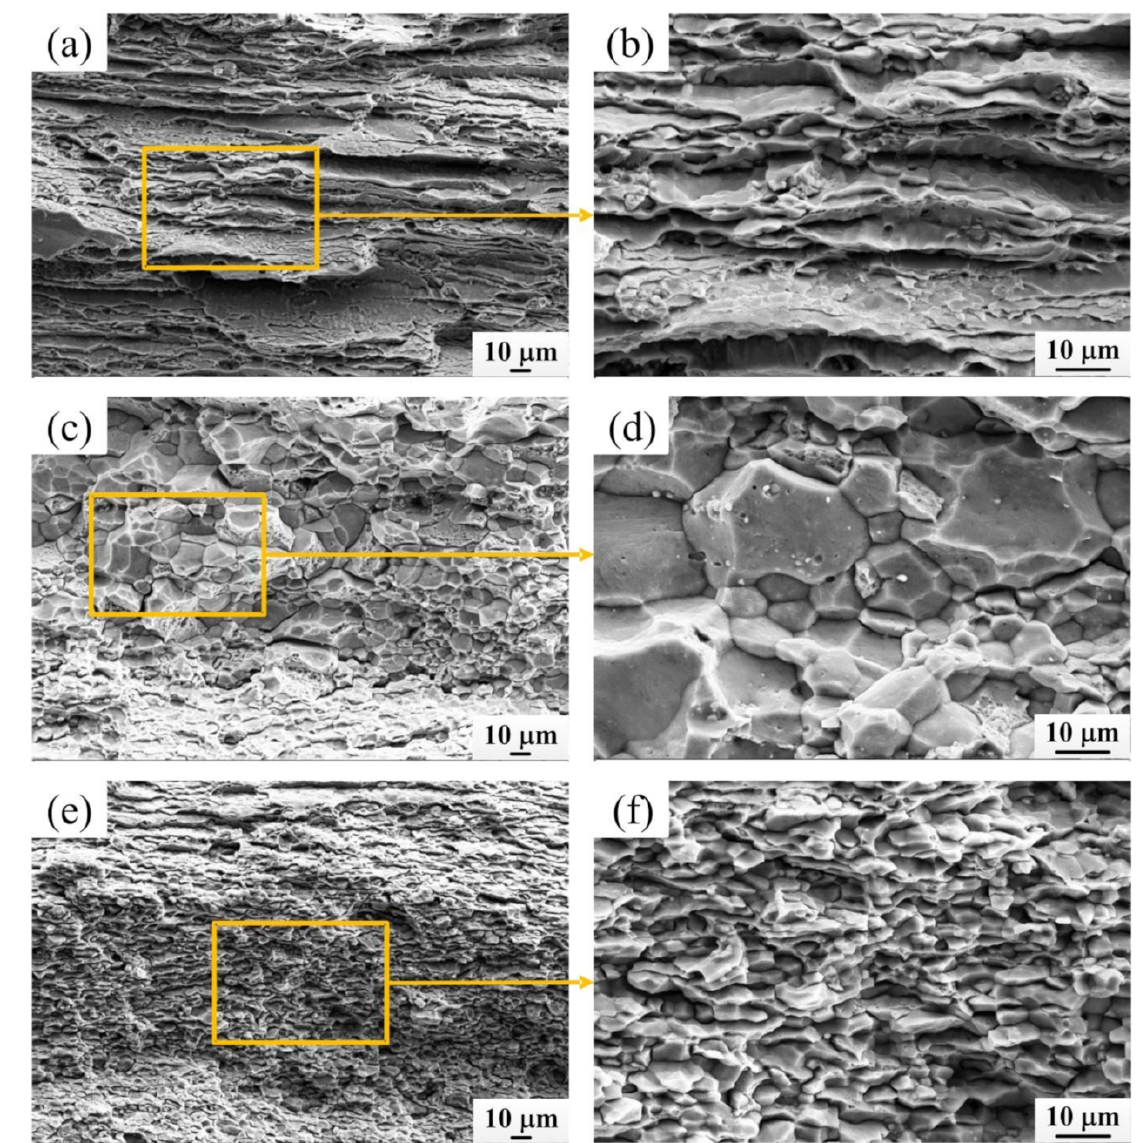
Figure 7. Fracture morphologies of the Al-Cu-Li alloy after aging: ingot ( a,b ); TRC alloy ( c,d ); electromagnetic TRC alloy ( e,f